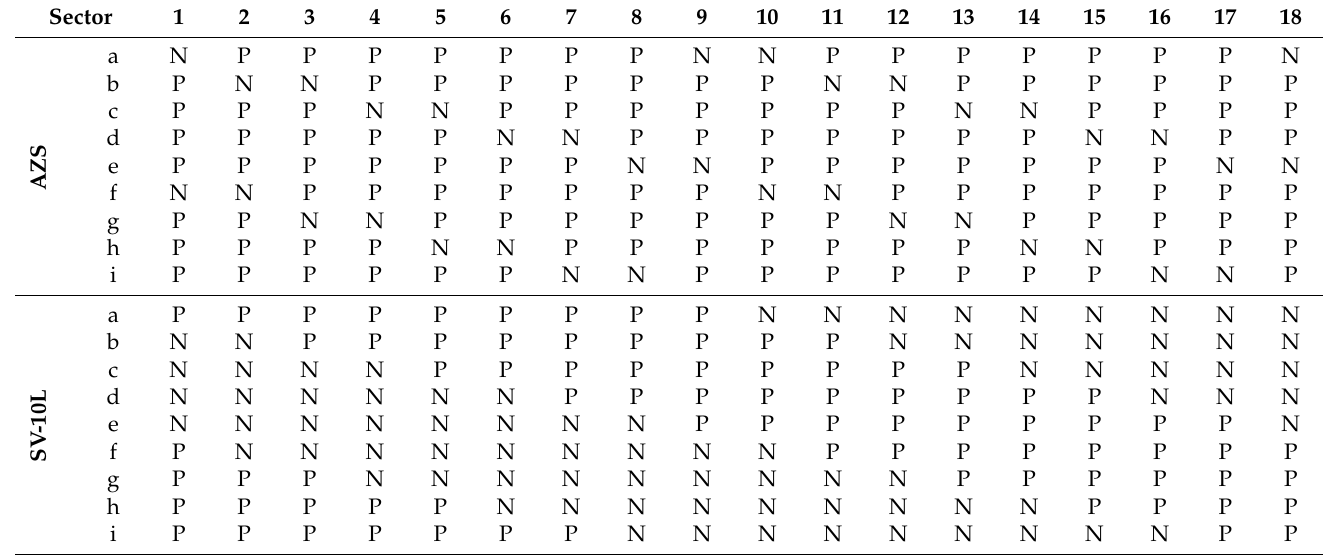
Table 6. Selection of Carrier Waves for The CBPWM of the Analyzed PWM